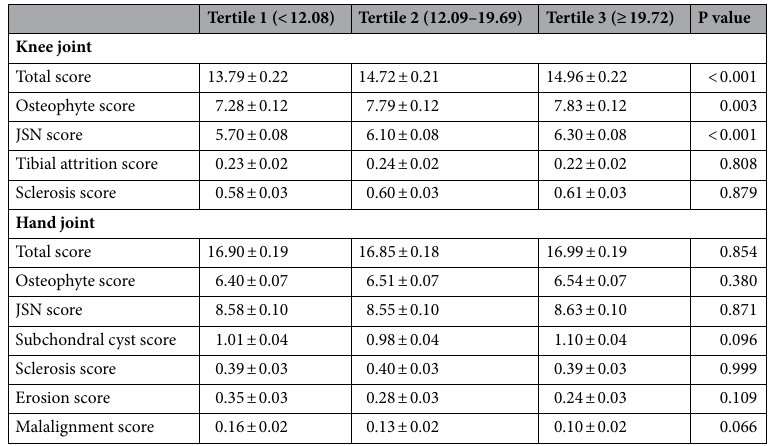
Table 2. Associations of serum adiponectin levels (μg/mL) tertiles with total and individual radiographic scores of knee and hand osteoarthritis. Values are adjusted for age, sex, body mass index, smoking, alcohol consumption, educational level, and physical activity. P values are for comparisons among all serum adiponectin levels tertiles. JSN joint space narrowing.